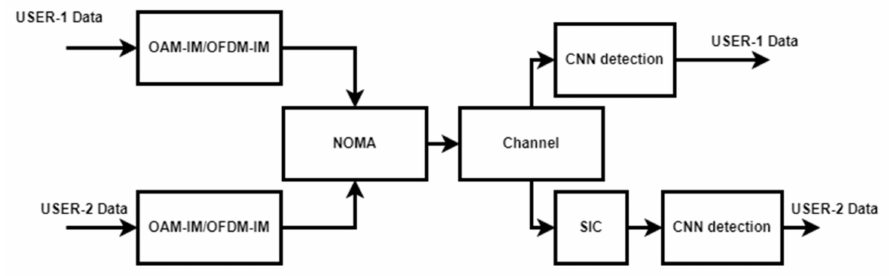
Figure 8. Proposed CNN-based NOMA-SIC multiuser